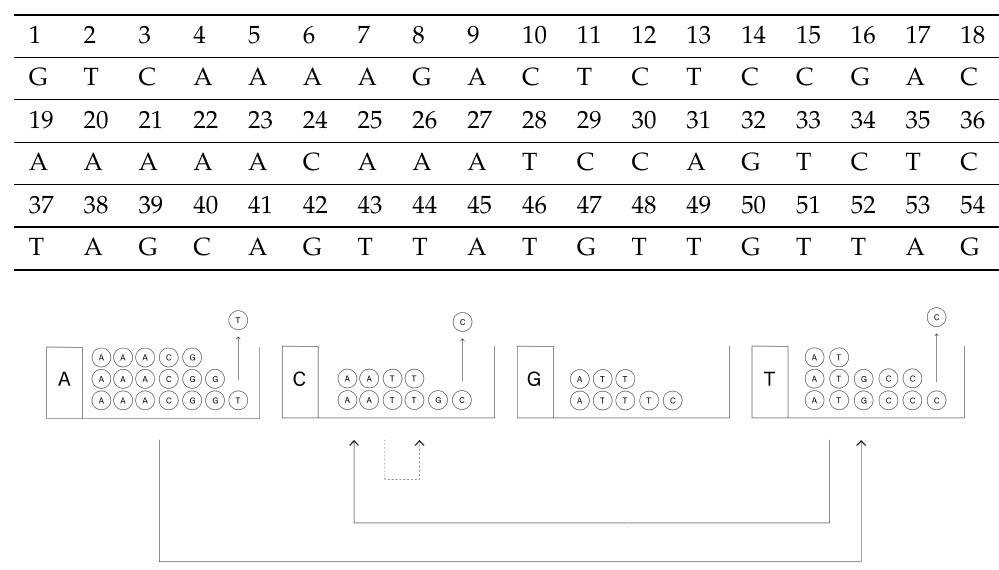
Figure 6. Illustration for Example